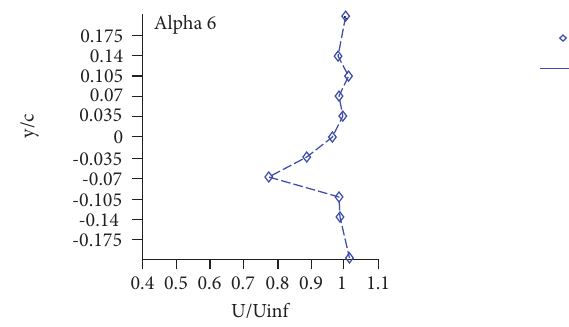
Figure 28. Streamwise velocity profile, pitch motion α (t) = 3 + 3 sin( w t), frequency = 3 Hz, Mach = 0.4.